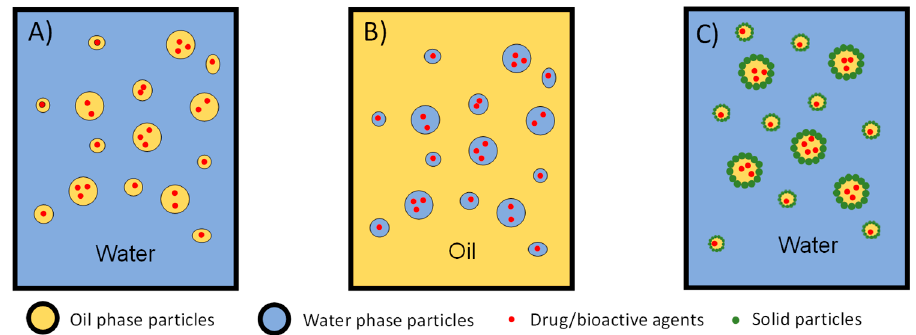
Figure 3. Encapsulation using emulsion techniques. ( A ) oil-in-water emulsion (O/W); ( B ) water- in-oil emulsion (W/O); ( C ) Pickering emulsion in an